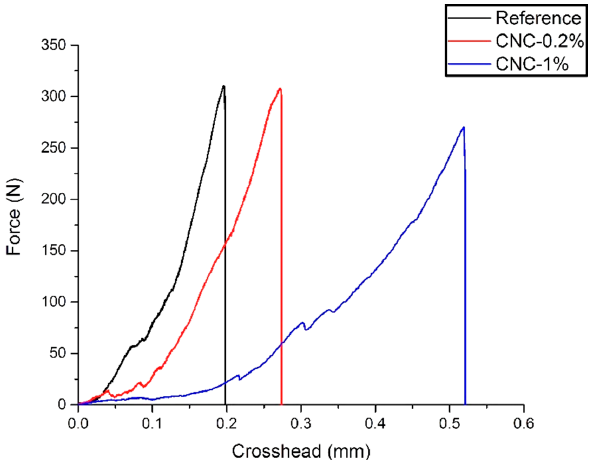
Figure 2. Three-point bending test for the three days samples.